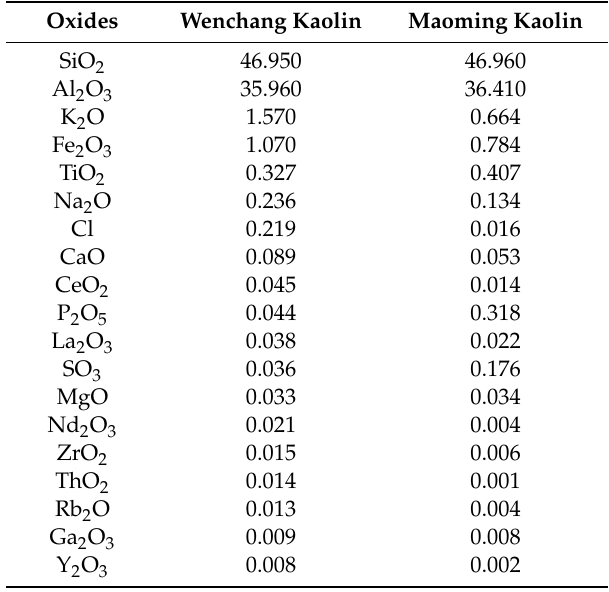
Table 1. Chemical compositions of two kaolin samples